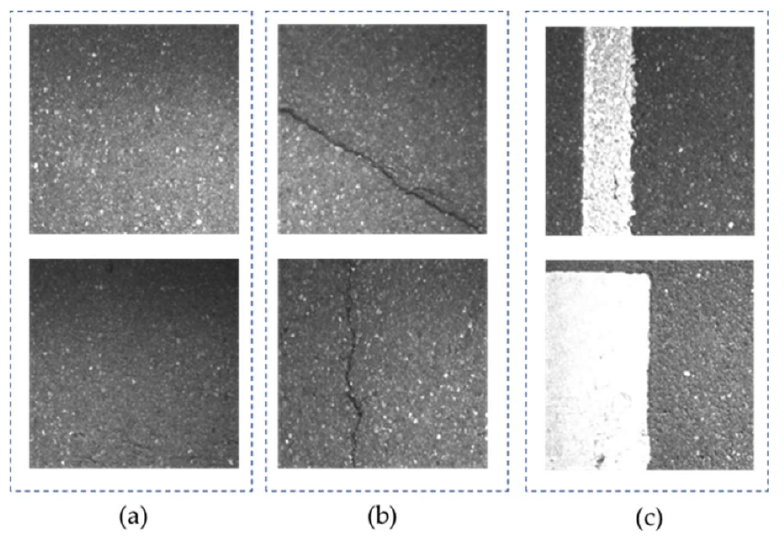
Figure 3. Example images from the GAPs dataset used in this study: ( a ) background, ( b ) crack, and ( c ) pavement